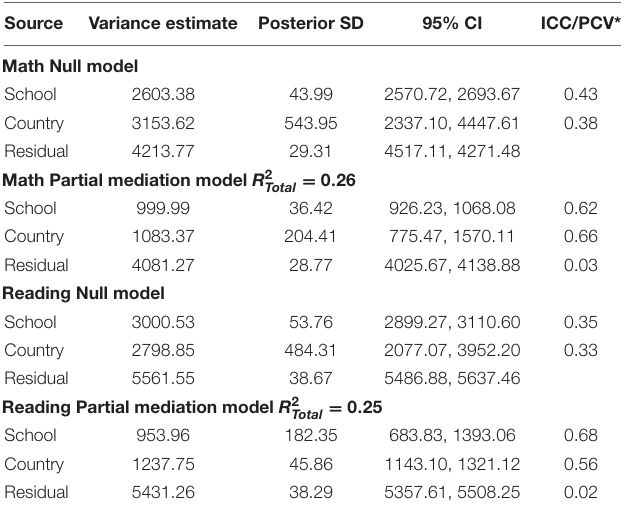
TABLE 5 | Fixed direct effects parameter estimates for partial mediation model: